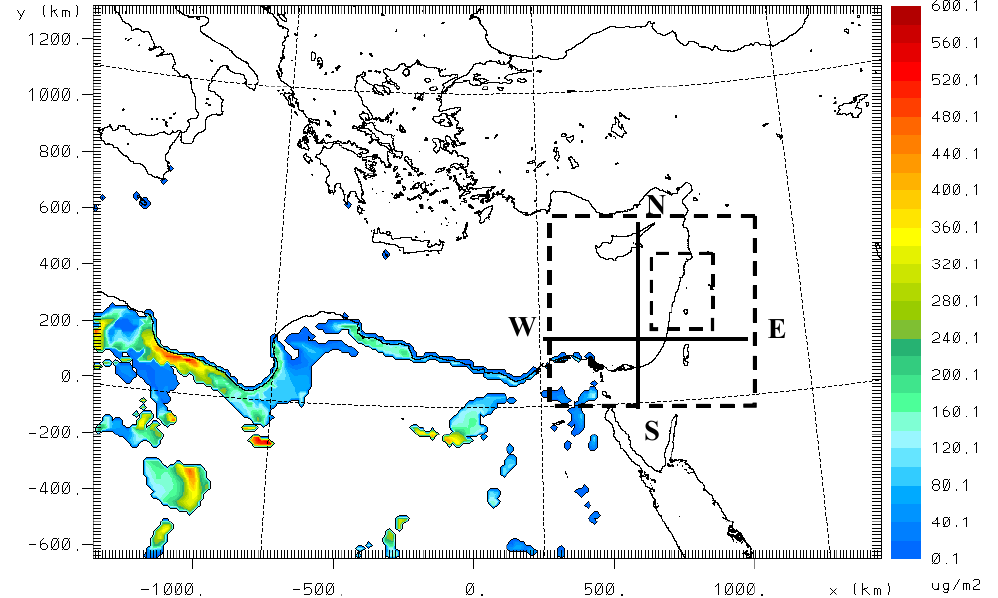
Fig. 7. Dust flux in µgm − 2 on 27 January 2003 09:00UTC. Dashed rectangles indicate the location of the nested domains. Solid lines indicate the locations of the cross sections of Fig. 8.